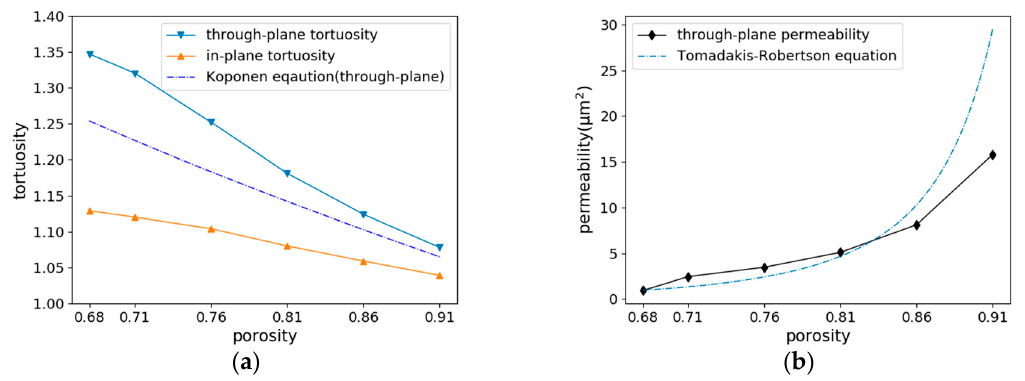
Figure 8. Calculated ( a ) tortuosity and ( b ) permeability of models with different porosities.